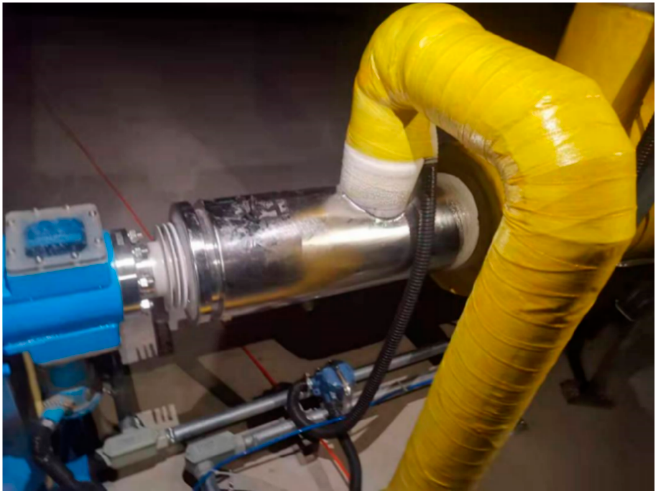
Figure 15. Liquid hydrogen pump pressurization test picture.